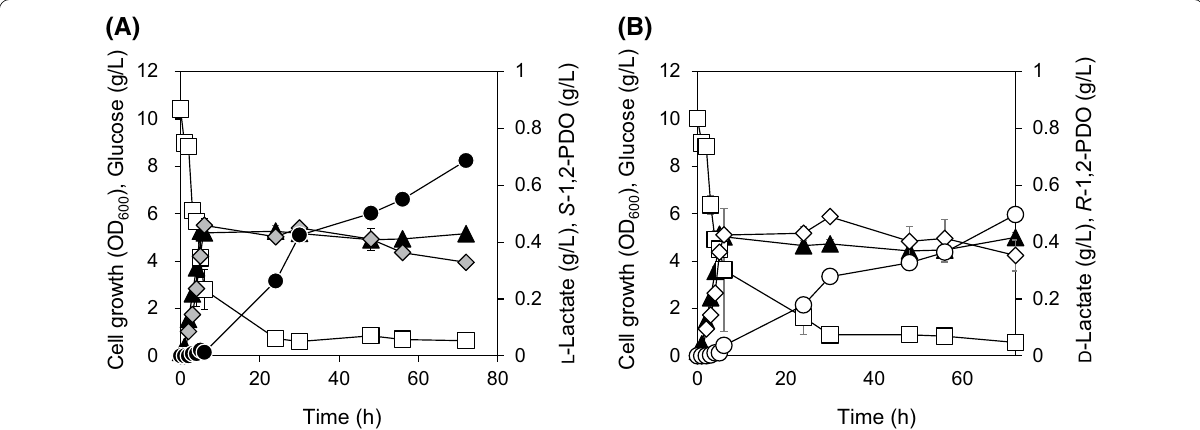
Fig. 2 Production of 1,2-PDO in A L. lactis LL1 and B LL2 with 1% glucose in flask cultivation. The recombinants were cultivated in M17 medium supplemented with 1% glucose for 72 h under microaerobic conditions. Closed triangles, cell growth (OD 600 ); closed circles, S -1,2-PDO; shaded diamonds, L-lactate; open circles, R -1,2-PDO; open diamonds, D-lactate; open squares, glucose. This experiment was performed in duplicate, and the average is represented with error